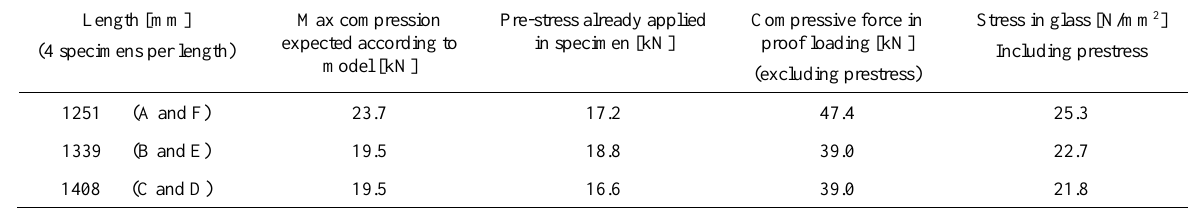
Fig. 8 Soft Aluminium cap to avoid peak stresses